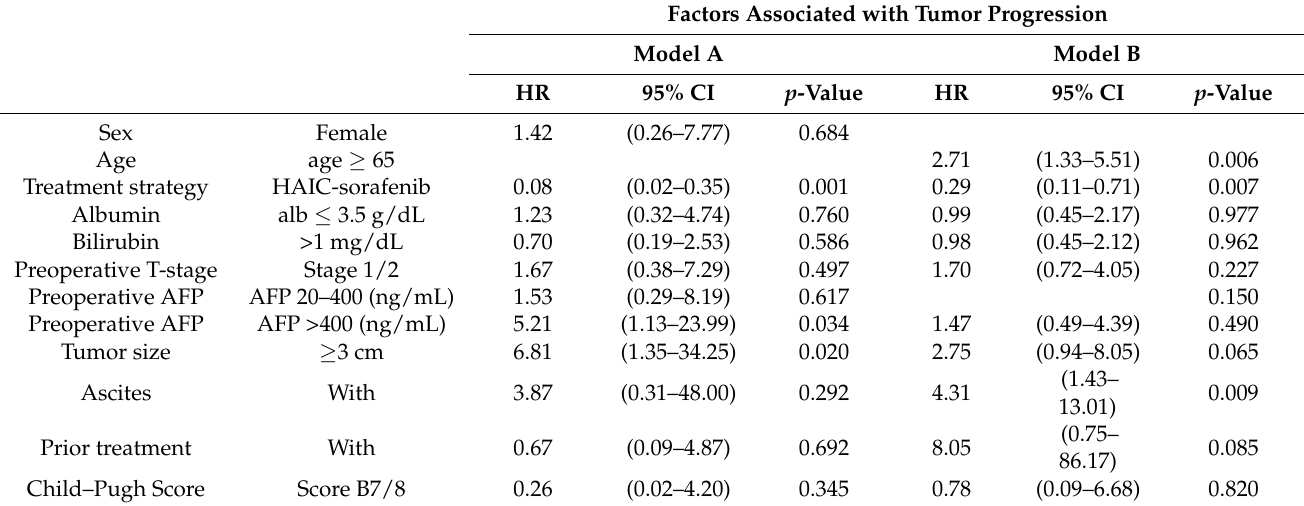
Table 3. Cox regression analyses of DFS in patients aged under 65 (A) and in males (B). Factors Associated with Tumor Progression Model A Model